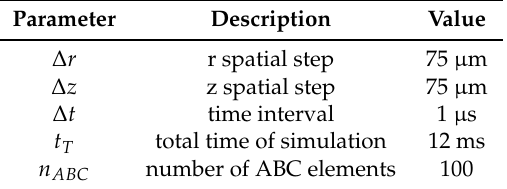
Table 5. Values of the parameters for the simulations by using the FDTD model.